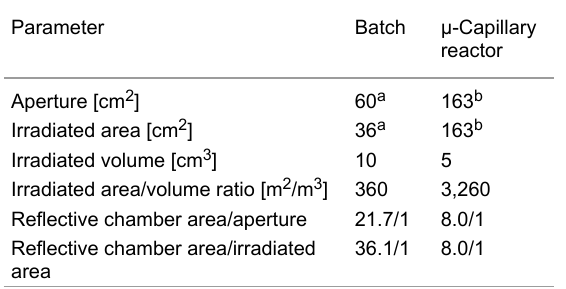
Table 3: Technical details of the two reactor types.